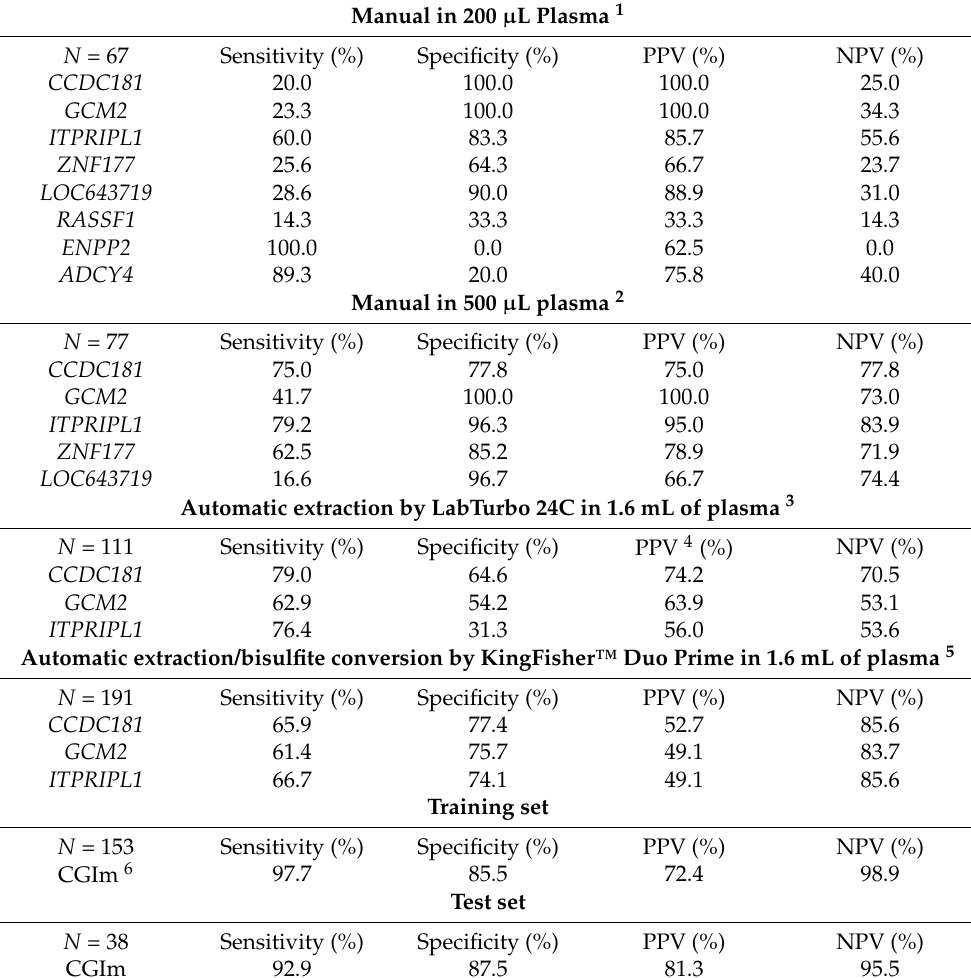
Table 2. Predictive value of the DNA methylation of the candidate genes for the early prediction of breast